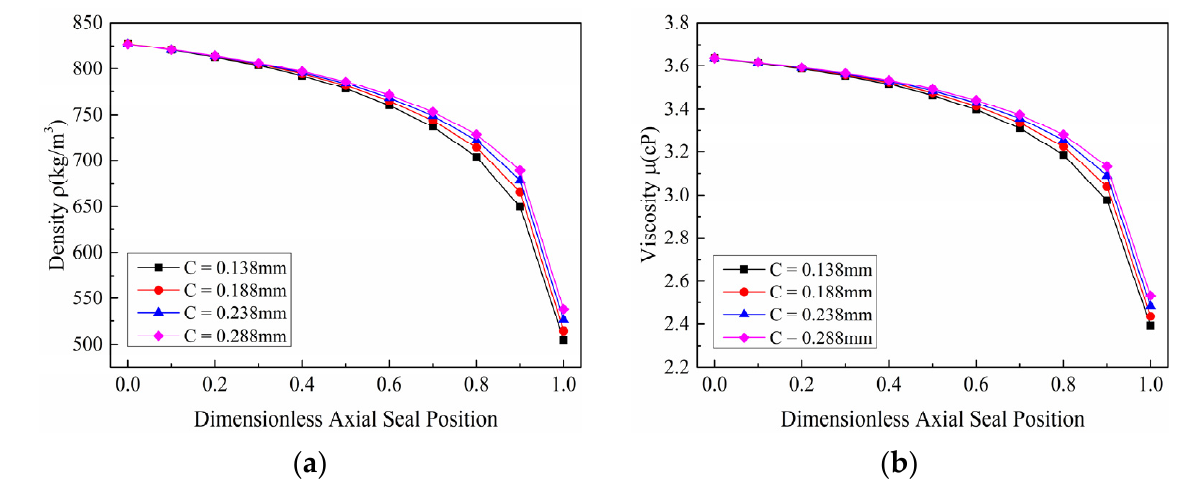
Figure 14. Mixture properties’ changes along the axial direction of the model seals with different clearances under the conditions of inlet GVF = 10%, Δ P = 48.3 bars. ( a ) Density changes, ( b ) viscosity changes.